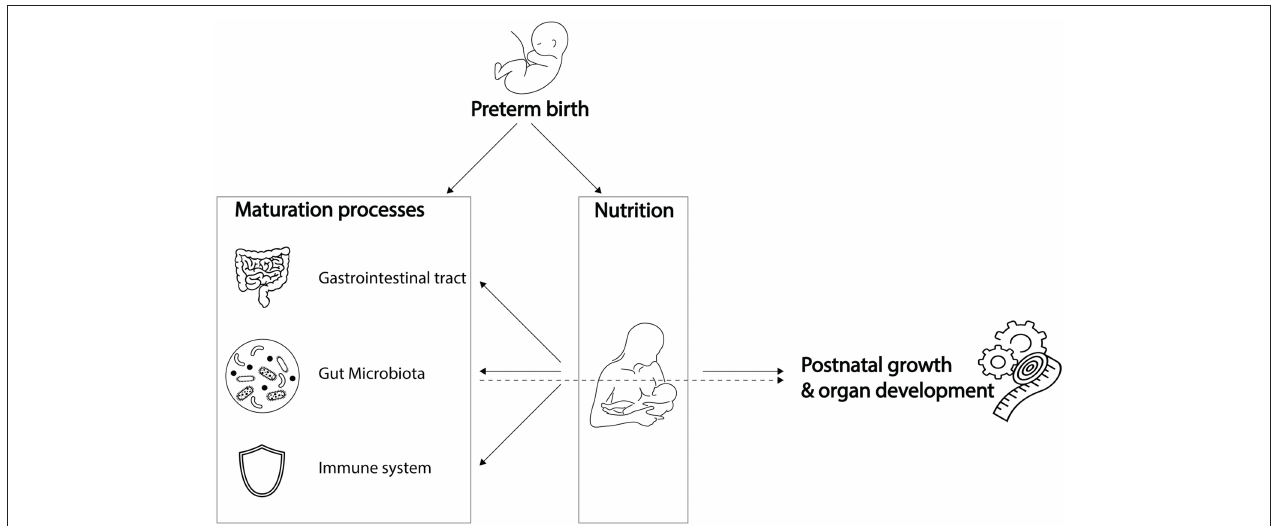
FIGURE 1 | Preterm birth influences breast milk composition and affects maturation processes. Breast milk stimulates maturation of the gastrointestinal tract, gut microbiota and immune system, which, together with its dietary components, promotes post-natal growth and organ development. While preterm birth influences breast milk composition and affects maturation processes, it remains unknown to what extent the preterm gut microbiota is involved in breast milk digestion, and how it contributes to post-natal growth and organ development. Icons were retrieved from The Noun Project. All retrieved icons are licensed as public domain or creative commons (CC BY). Icons were designed by: Cristiano Zoucas (Measuring tape), Design Science (Immune System), Gregor Cresnar (Gears), Jannie Henderickx (baby), Julia Amadeo (Gastrointestinal tract), Julie McMurry (breastfeeding), and Maxim Kulikov (Gut